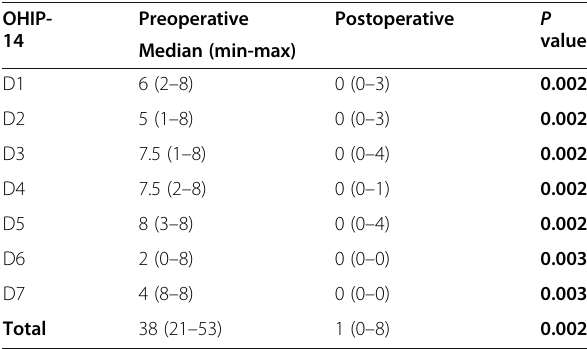
Table 1 Comparison of OHIP-14 and its domains in the pre-and postoperative